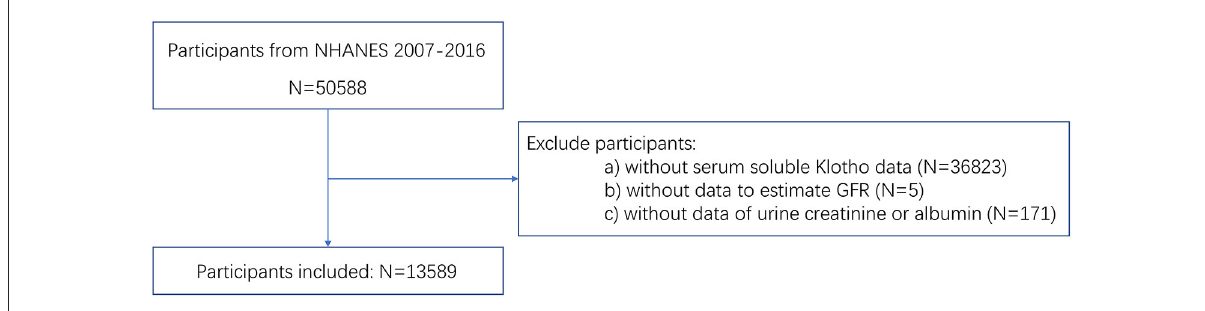
FIGURE1 Flowchart of participants